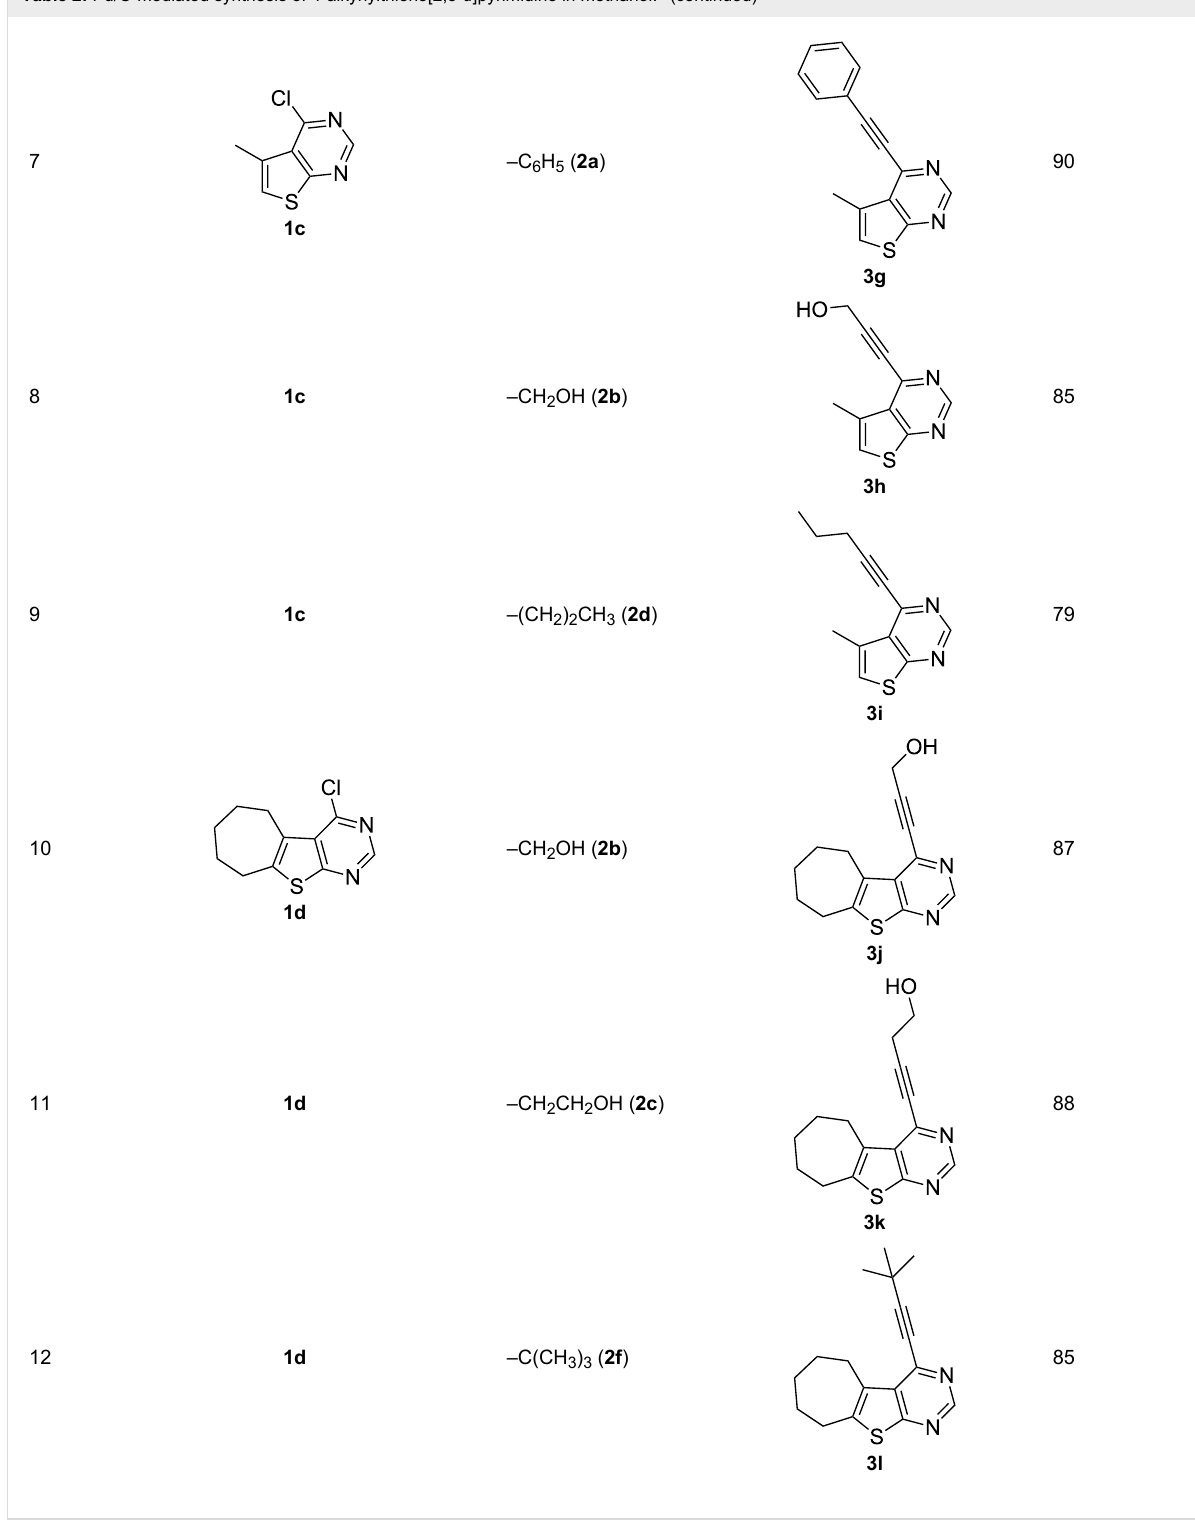
Table 2: Pd/C-mediated synthesis of 4-alkynylthieno[2,3- d ]pyrimidine in methanol. a